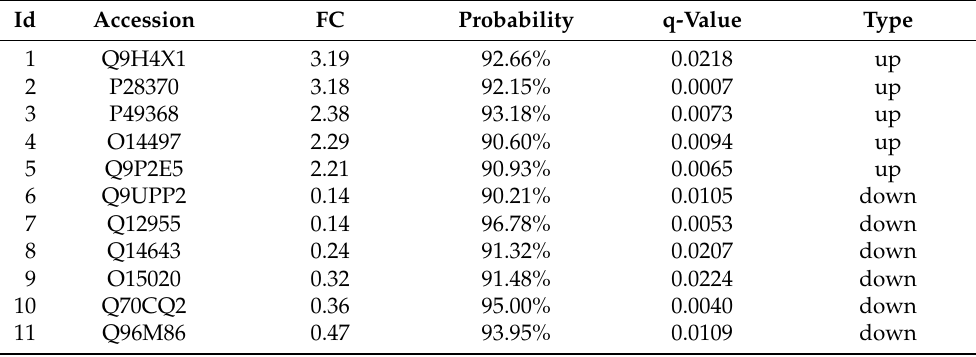
Figure 4. T-SNE visualization of verified proteins and predicted candidates using 260 features. Table 2. The potential glioma biomarkers identified using our